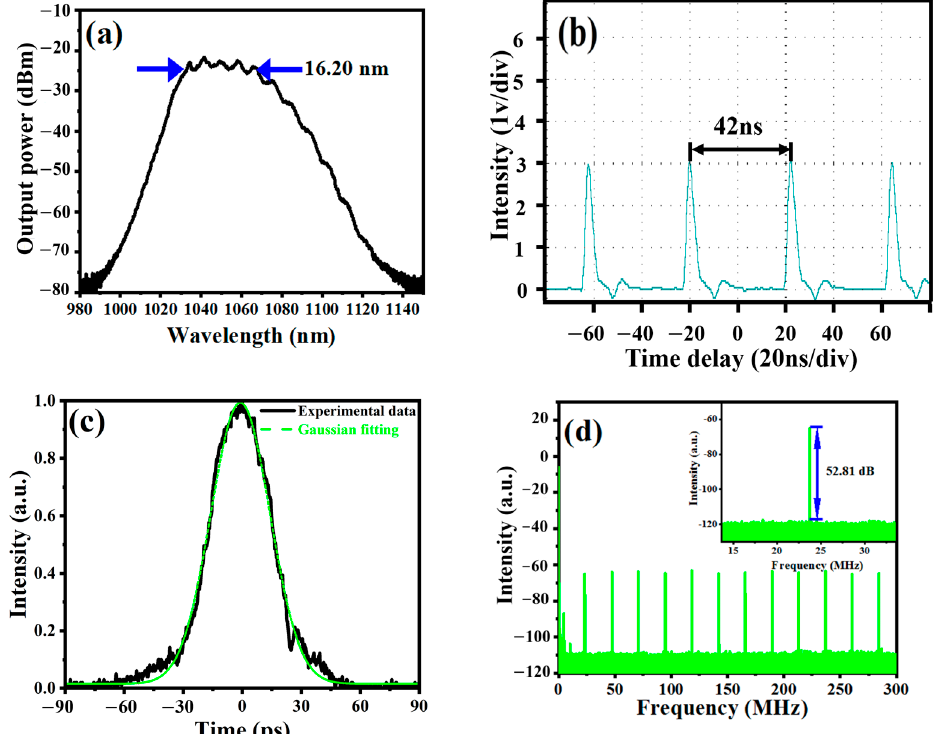
Figure 4. Output characeteristics with a filter bandwith of 4.84 nm. ( a ) Output spectrum. ( b ) Pulse train. ( c ) Autocorrelation trace. ( d ) RF spectrum.